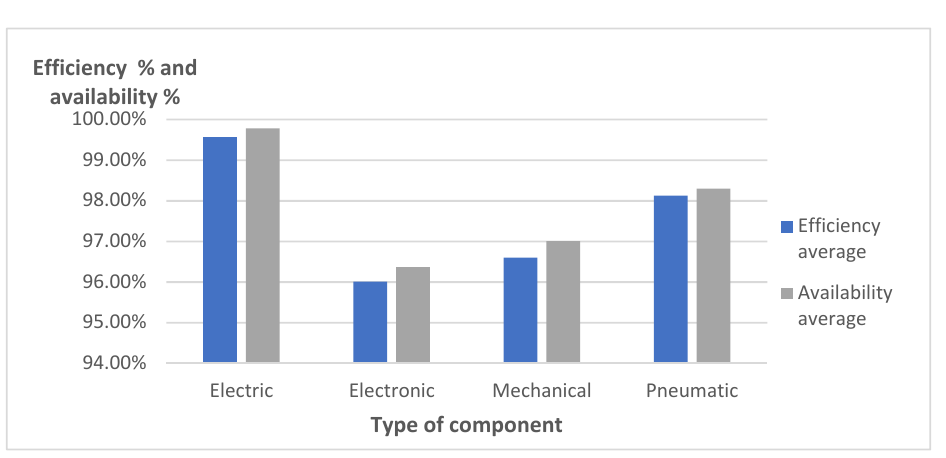
Figure 3. Average efficiency and availability values in % by type of component with the PPM strategy. Electrical components have the higher average values of efficiency and availability, with a maximum value of 99.71% in efficiency and availability.